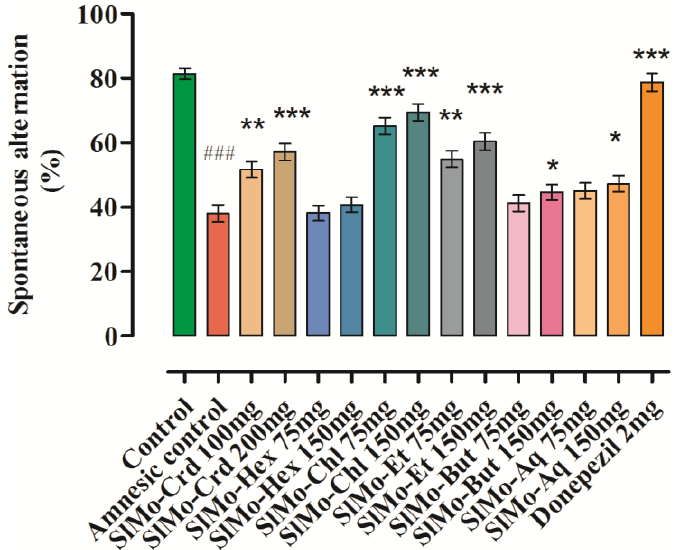
Figure 2. Effect of crude methanolic extract and fractions of S. moorcroftiana on mice for memory in behavioral Y-maze test. Mean ± SEM ( n = 6). One-way ANOVA followed Dunnett’s post hoc multiple comparison test to calculate the values of p . ### p < 0.001 is comparison of scopolamine-treated (amnesic) group with normal control, * p < 0.05, ** p < 0.01 and *** p < 0.001 represents comparison of scopolamine-treated (amnesic) group vs Donepezil, crude extract and fractions-treated groups.